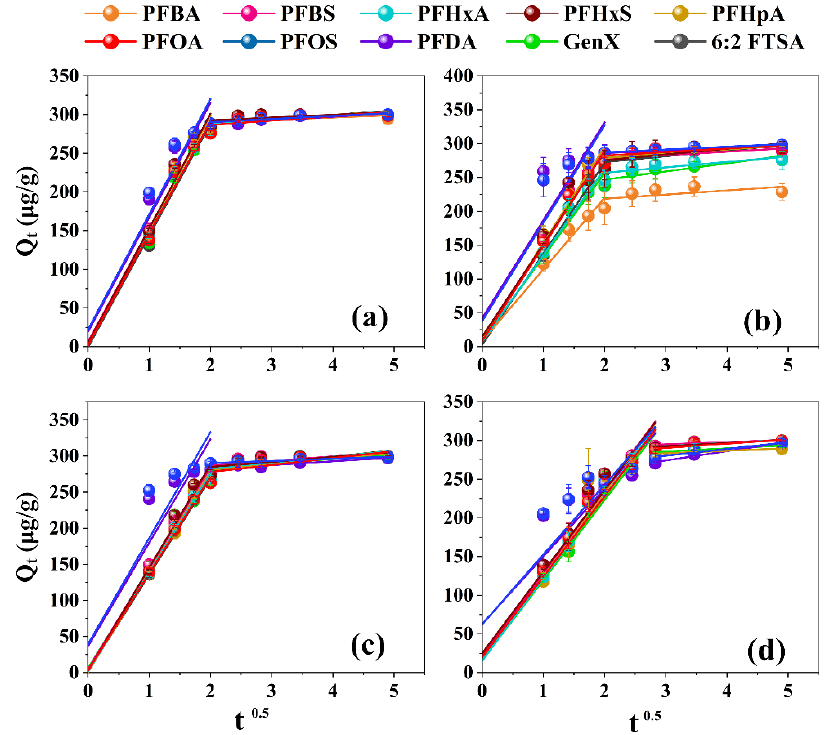
Figure 3. Weber-Morris IPD model curve for the adsorption of PFASs onto different resins: ( a ) HPR4700; ( b ) WA10; ( c ) S6368; ( d ) A111S. ( a ) HPR4700; ( b ) WA10; ( c ) S6368; ( d )